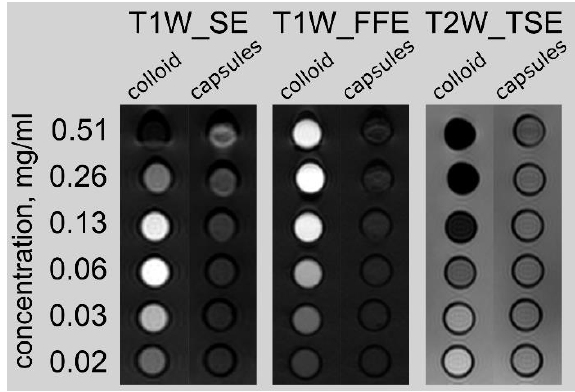
Figure 2. The MRI contrast of the magnetite colloid and magnetic microcapsules at a different concentrations of magnetite in the probe tubes. Different pulse sequences are presented from left to right: T1 weighted “Spin-echo” (T1W_SE), T1 weighted “Fast Field Echo” (T1W_FFE), and T2 weighted “Turbo Spin Echo” (T2W_TSE).